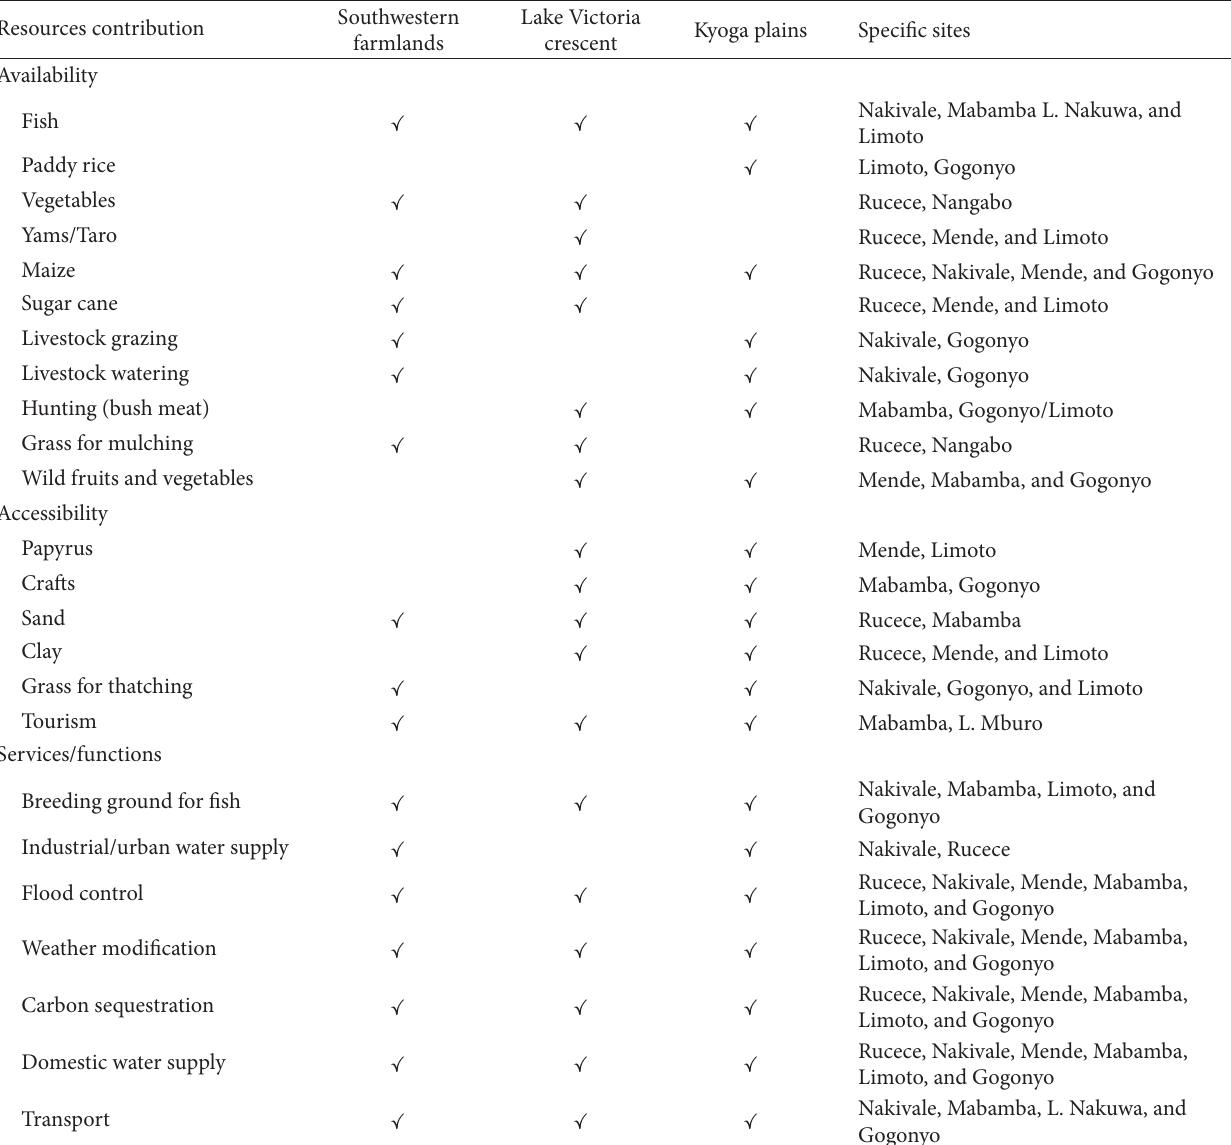
Table 1: Wetland resources considered for economic valuation in